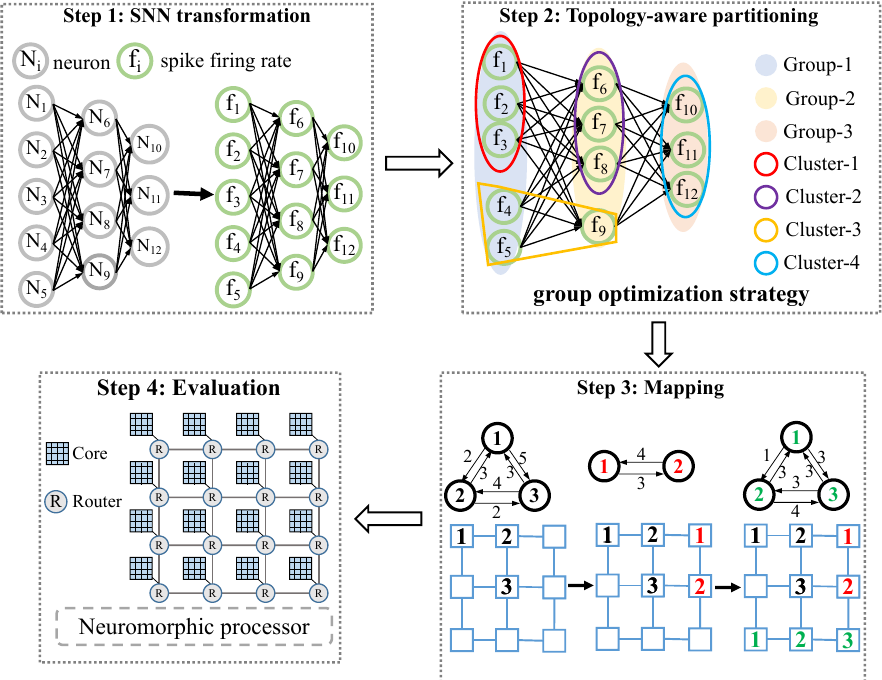
Figure 4. High-level overview of